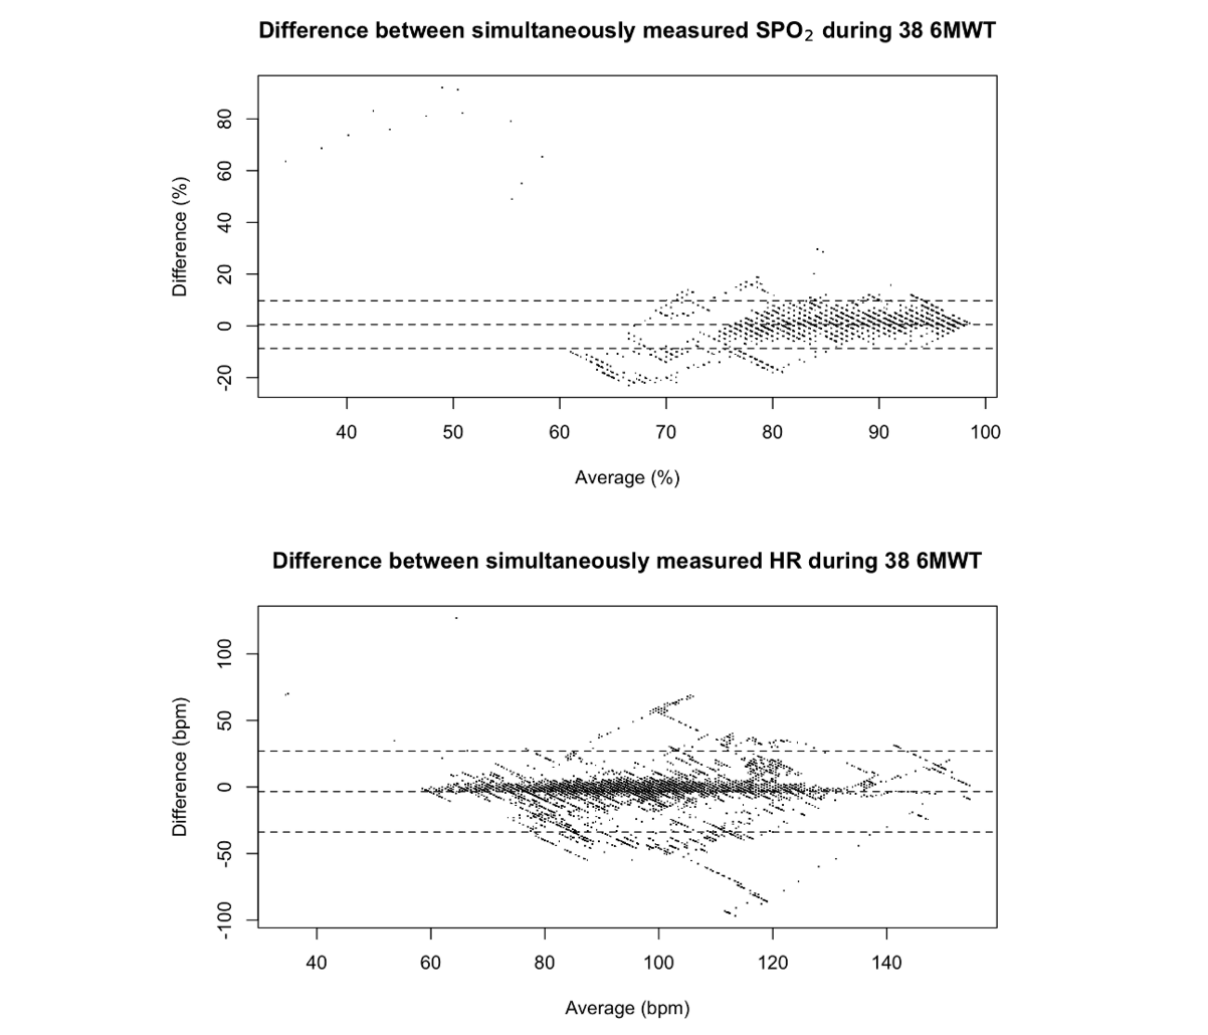
Figure 8. Bland-Altman plots of the differences between 19,356 matched samples of SpO 2 and heart rate values measured simultaneously by